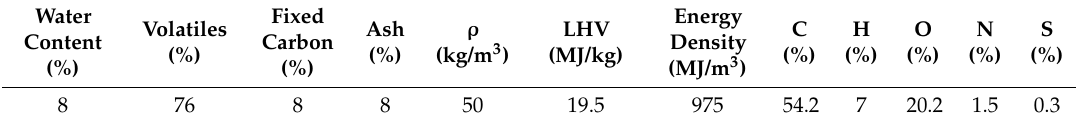
Table 6. Proximate analysis, ultimate analysis and energy